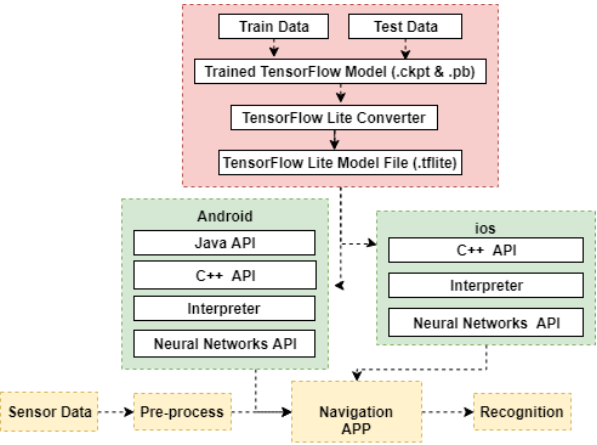
Figure 4. Filtered MEMS